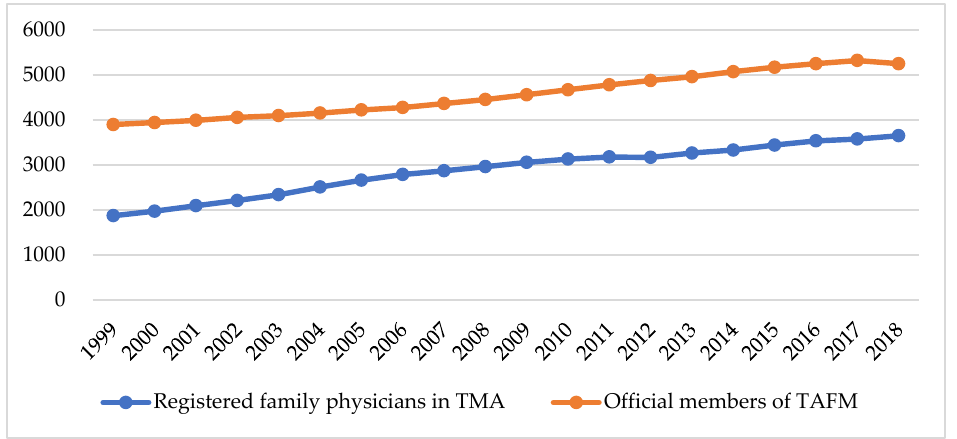
Figure 1. Changes in the ratio of physicians registered as family physicians in TMA and number of members enrolled in TAFM in Taiwan from 1999 to 2018.